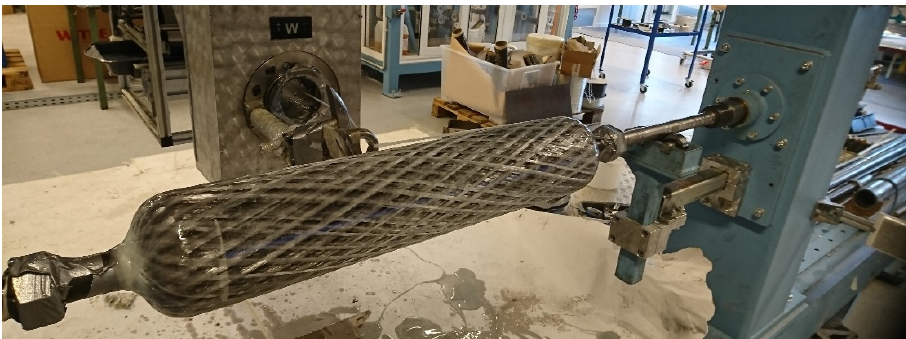
Figure 2. Winding of the first axial layer of the pressure vessel.